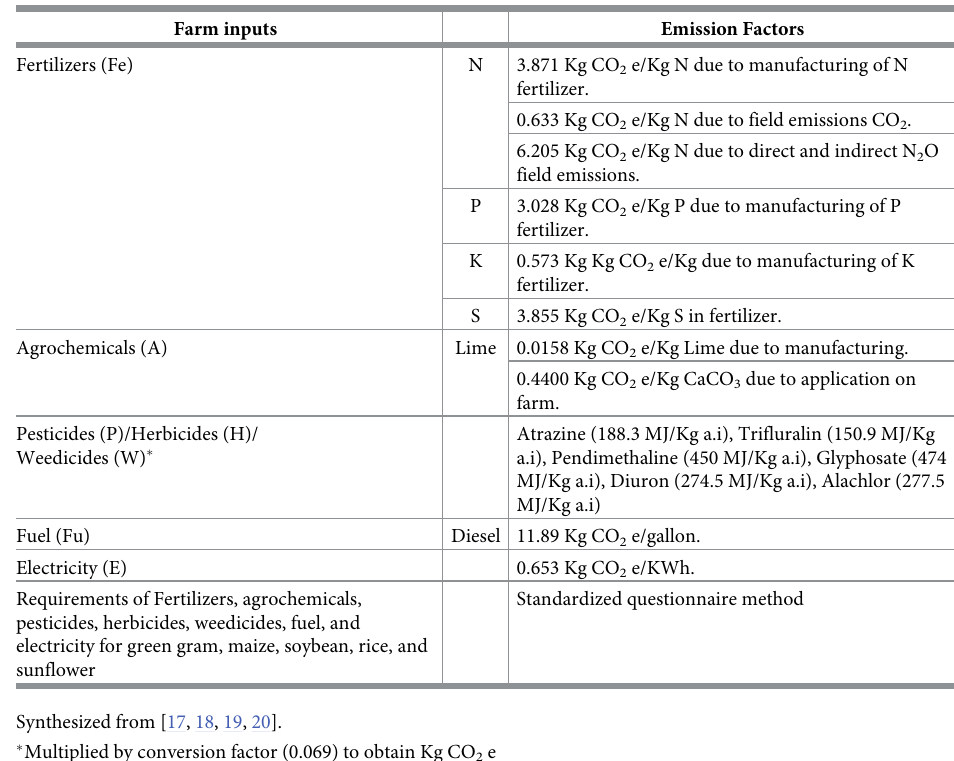
Table 2. Requirements and emission factors of various farm